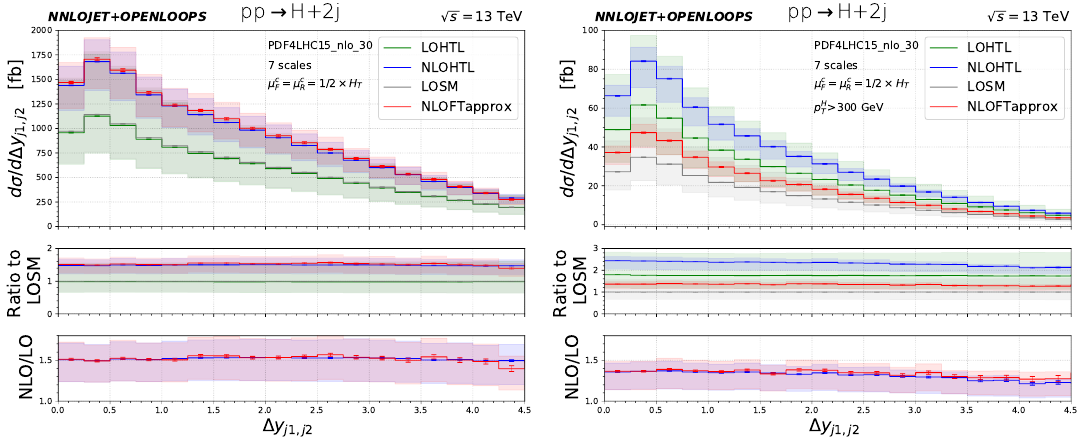
Figure 7 . Rapidity difference between the two hardest jets in H + 2 jets production. Colour coding and labelling as in figure